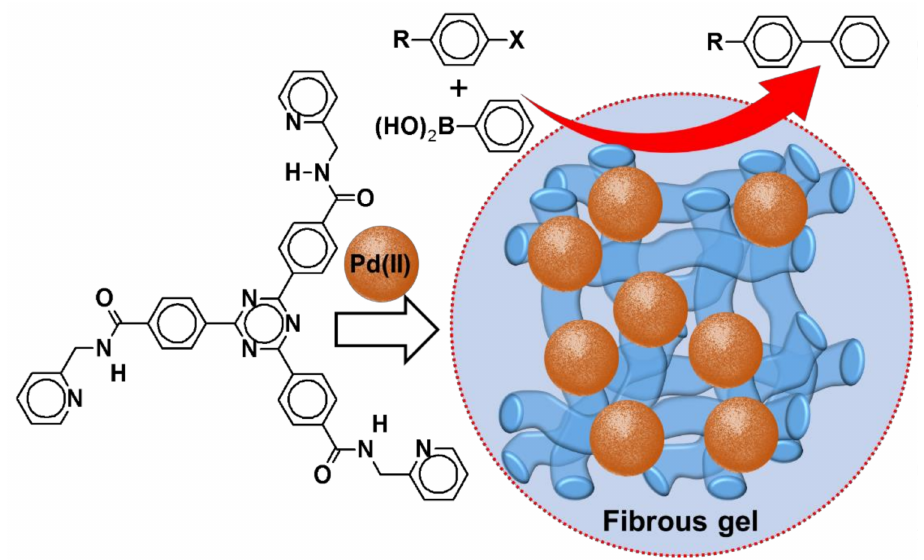
Figure 48. A metallogel formed from the self-assembly of a palladium salt and a C 3 -symmetric multidentate pyridine-based tripodal ligand in CH 3 OH/CHCl 3 solution and a Suzuki–Miyaura coupling using the fibrous